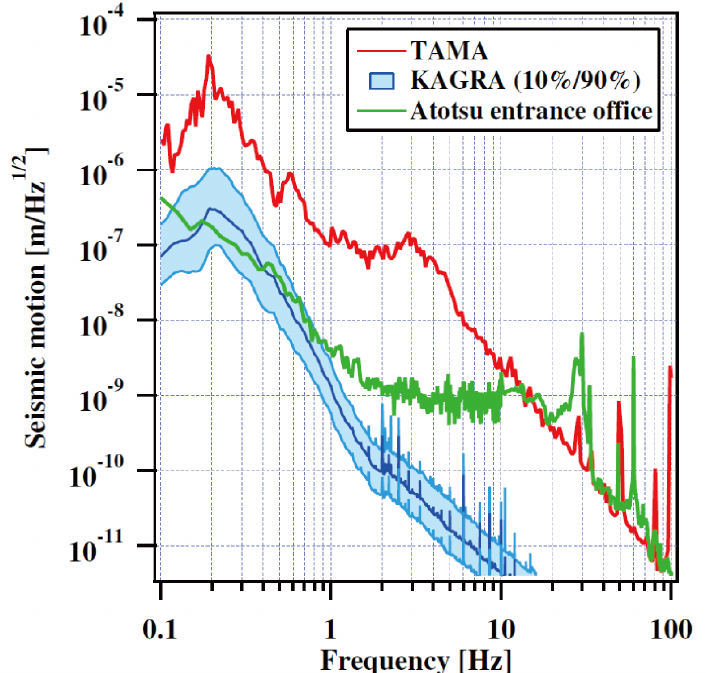
Figure 4. Seismic noise at the TAMA300 site (TAMA), the entrance of the KAGRA tunnel (Atotsu entrance), and the KAGRA site (KAGRA). For the seismic noise of the KAGRA site, the 10th and 90th percentile lines (upper and lower cyan lines, respectively) are shown in the figure. Reprinted with permission from Ref. [8], ©2021 Oxford University